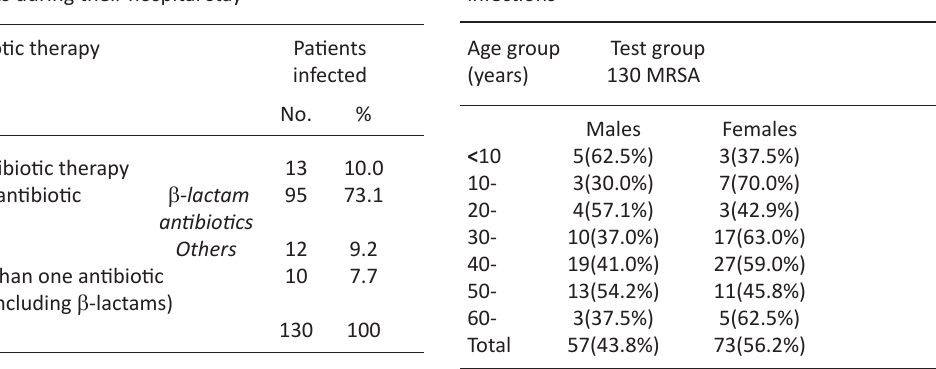
Table 3. Age and gender distribution of the 130 MRSA